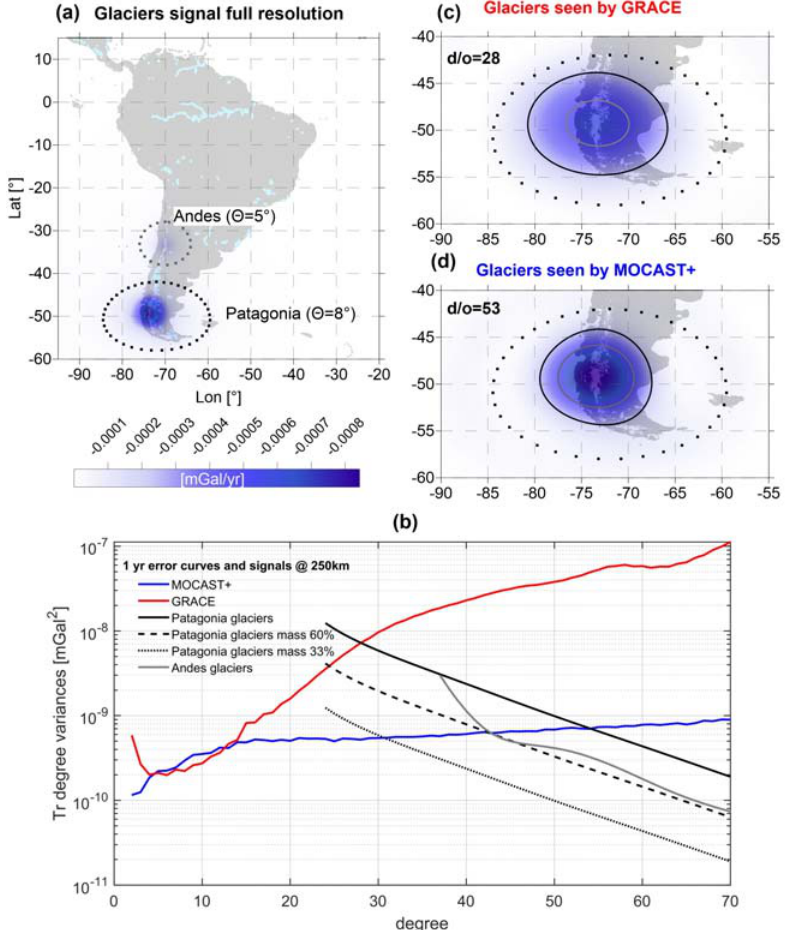
Figure 9. ( a ) Gravity effect at 250 km altitude of the deglaciation and window caps considered for Andes glaciers and Patagonian glaciers; ( b ) spectra of yearly deglaciation signals for glaciers in South America in comparison with MOCAST+ and GRACE error curves. Rates expressed as the gravity change accumulated in one year. ( c , d ) Glaciers’ signal perceived by GRACE ( c ) and MOCAST+ ( d ). MOCAST+ resolves the signal to 380 km half-wavelength, and GRACE to 715 km. Contour lines of 0.00025 mGal/yr (black) and 0.0005 mGal/yr. Both simulations in spatial and spectral domains were computed at 250 km altitude.